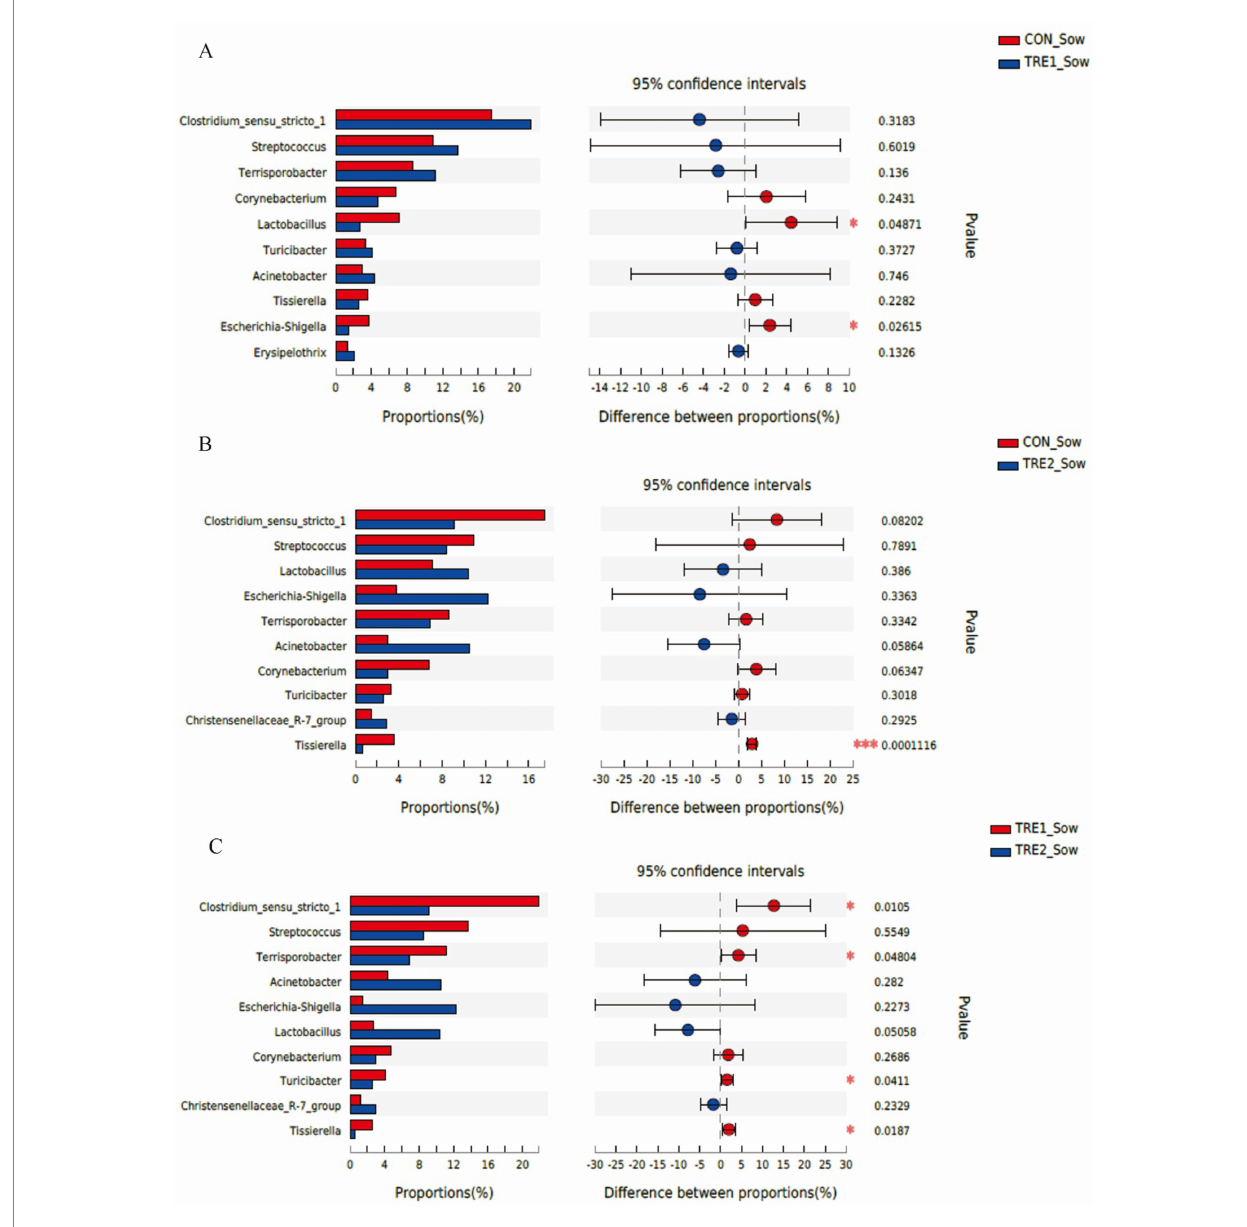
FIGURE 7 Differences in fecal microbiota of sows at genus level among different groups. (A) The difference in fecal microbiota for sows between the control group and TRE1 group. (B) The difference in fecal microbiota for sows between the control group and TRE2 group. (C) The difference of fecal microbiota for sows between TRE1 and TRE2 groups. Sows are regarded as the experimental units, N = 5 for each